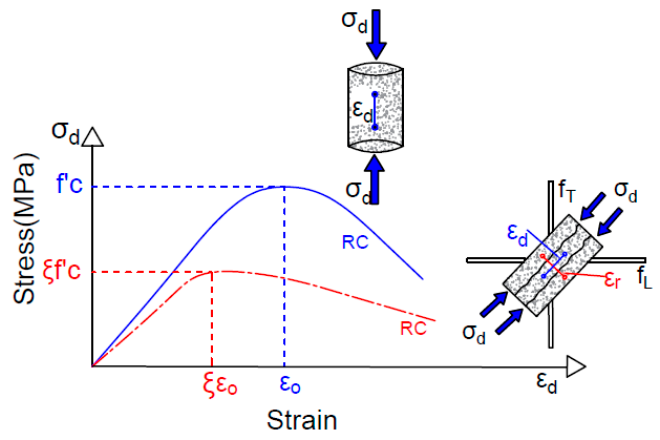
Figure 2. Softening behavior of concrete.